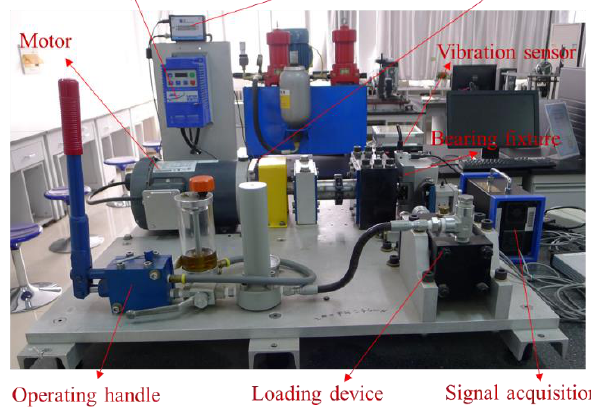
Figure 8. Accelerated life test bench of the rolling bearing.